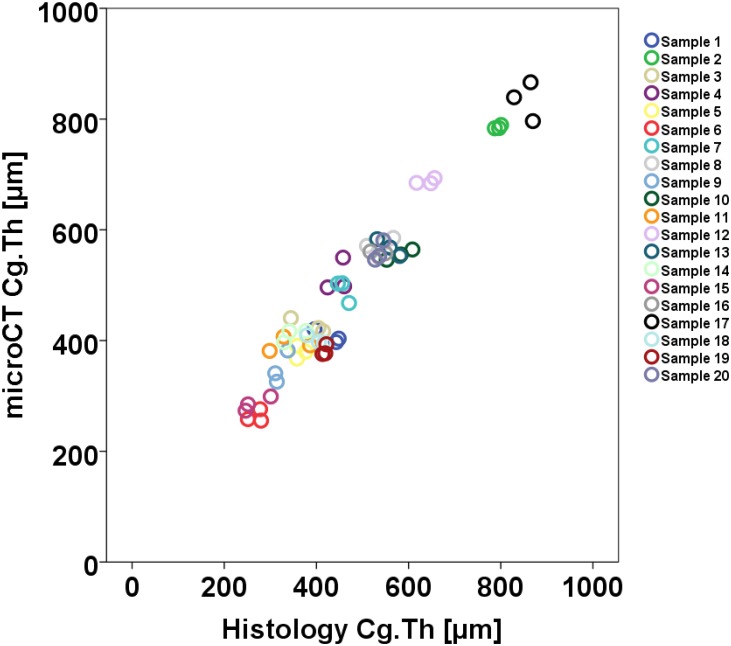
User reproducibility for cartilage segmentation.Plot of 2D cartilage thickness (Cg.Th) measured by three users segmenting a random selection of matching microCT and histology images; 10 femur and 10 tibia image pairs from both NO and OP joints, demonstrating user independence of the segmentation procedure. ICC (microCT) = 0.996 (0.992, 0.998); ICC (histology) = 0.993 (0.984, 0.997), p < 0.001.